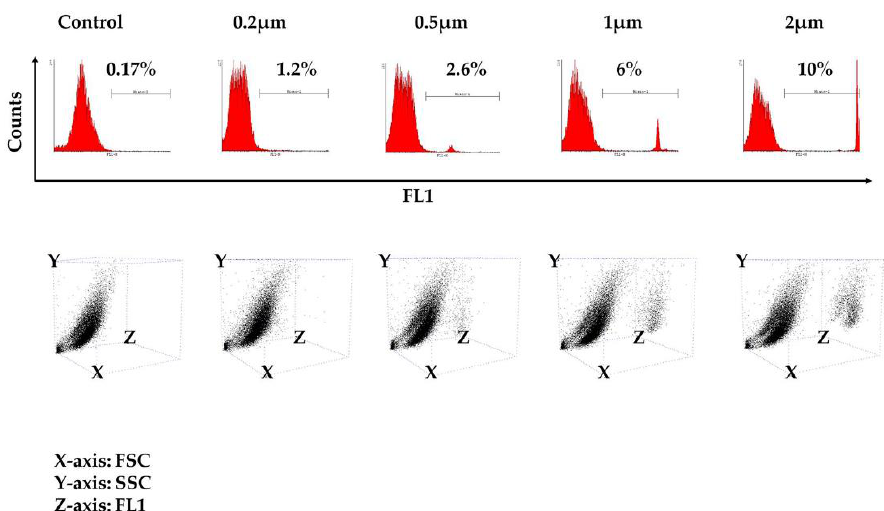
Figure 3. Macrophage phagocytosis assay. Results shown after flow cytometry analysis from one representative experiment. Histograms on the top illustrate the percentage of macrophages presenting phagocytosis events after a 24-hour exposure to variously-sized fluorescent beads (0.2 μm, 0.5 μm, 1 μm and 2 μm). The respective 3D dot plots are depicted on the bottom of the page. Note that both cell populations (i.e., from Region A and Region B) appear to possess phagocytic properties. Macrophages not exposed to beads served as a negative control. FSC: forward scatter; SSC: side scatter.